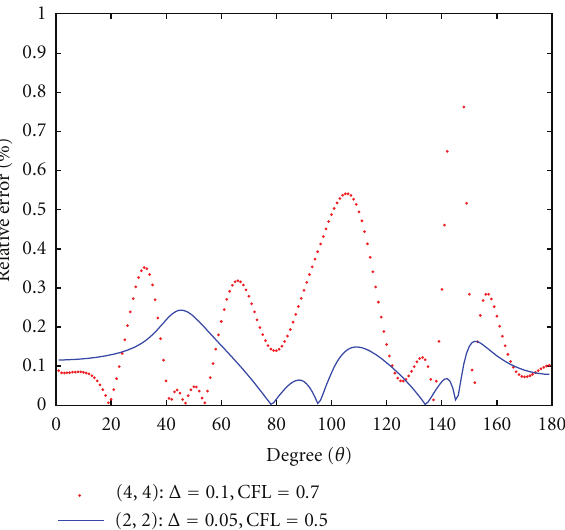
Figure 7: The relative error of computed E -plane RCS with (4,4) and (2,2) schemes.